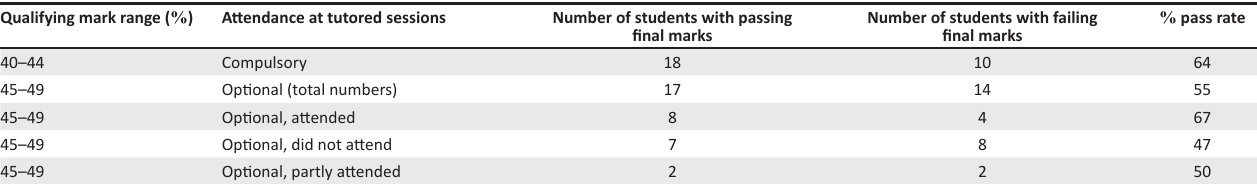
TABLE 2: Final results after the January 2015 mathematics tutored reassessment programme. Qualifying mark range ( %